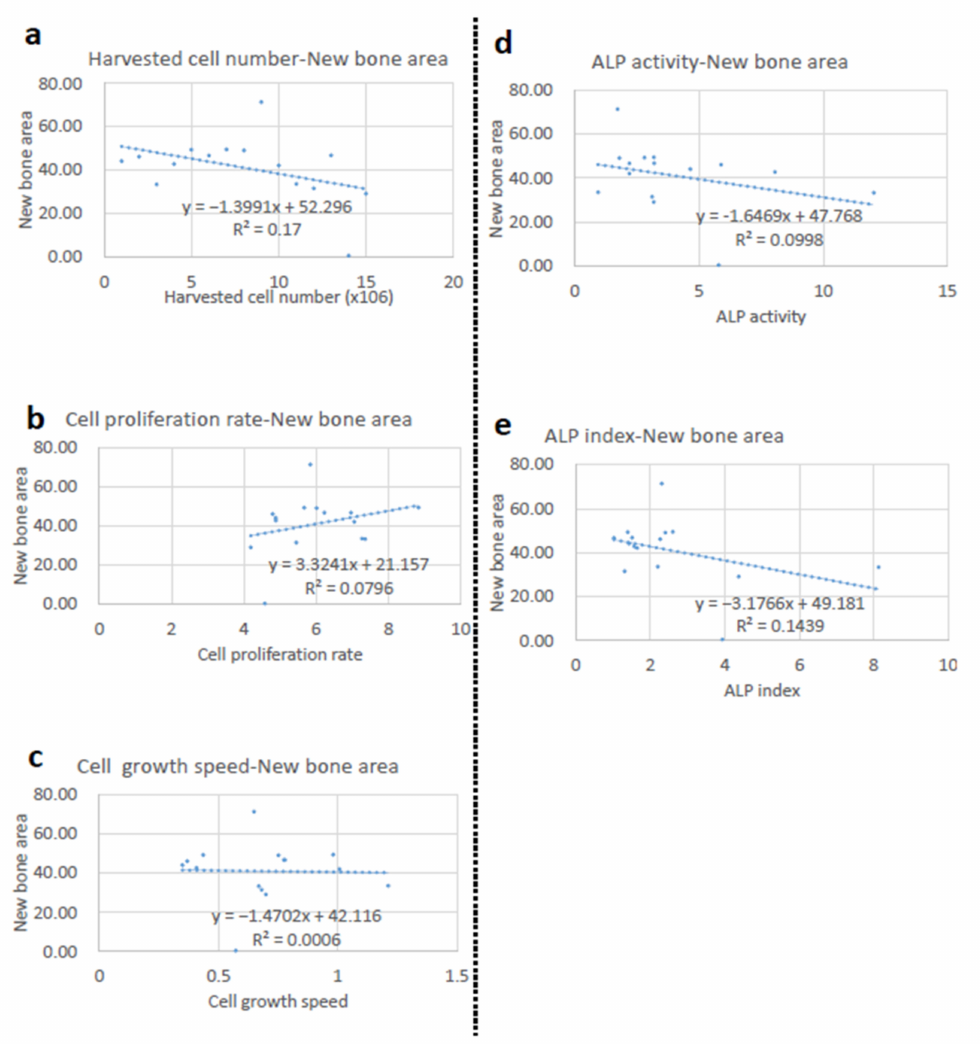
Figure 10. Correlation between the new bone area and cellular parameters. ( a ) Correlation between harvested cell number and new bone area. ( b ) Correlation between cell proliferation rate and new bone area. ( c ) Correlation between cell growth speed and new bone area. ( d ) Correlation between ALP activity and new bone area. ( e ) Correlation between ALP index and new bone